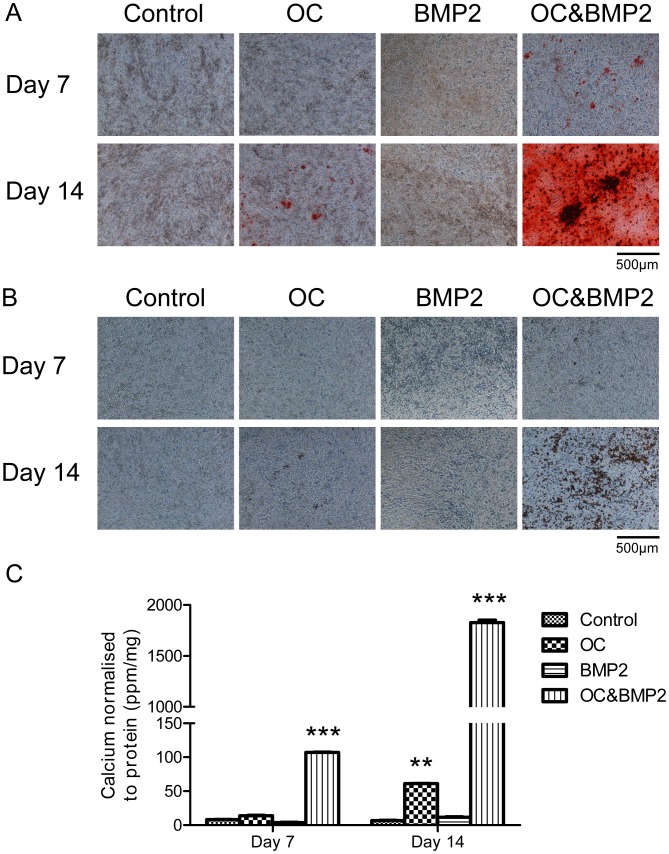
The effect of exogenous BMP2 on 4T1 cell mineralization.Representative images were captured at 100× magnification and the scale bars represent 500 µm. Positive staining for calcium (red) and calcium phosphate (black/brown) were observed in the OC&BMP2 group by day 7 and increased in intensity by day 14, as shown by alizarin red S (A) and von Kossa (B) staining. Positive staining was detected in the OC group by day 14 using both alizarin red S and von Kossa stains. (C) The calcium content of 4T1 cells as determined by the o-cresolphthalein calcium assay normalized to protein. By day 14 the calcium levels of the OC&BMP2 group are 30-fold greater than the OC group. Each point represents the mean amount of calcium measured in ppm normalized to protein measured in mg, +/− SEM, n = 3, two-way ANOVA. **P<0.01 OC vs. control on day 14. ***P<0.001 OC&BMP2 vs. all other groups on days 7 and 14. OC (osteogenic cocktail) = 50 µg/ml ascorbic acid and 10 mM β-glycerophosphate. BMP2 = 100 ng/ml human recombinant bone morphogenetic protein 2.